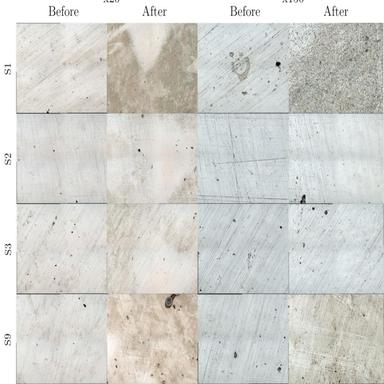
304 stainless steel sample, combined laser and optical images obtained by 3D profilometry before and after testing.